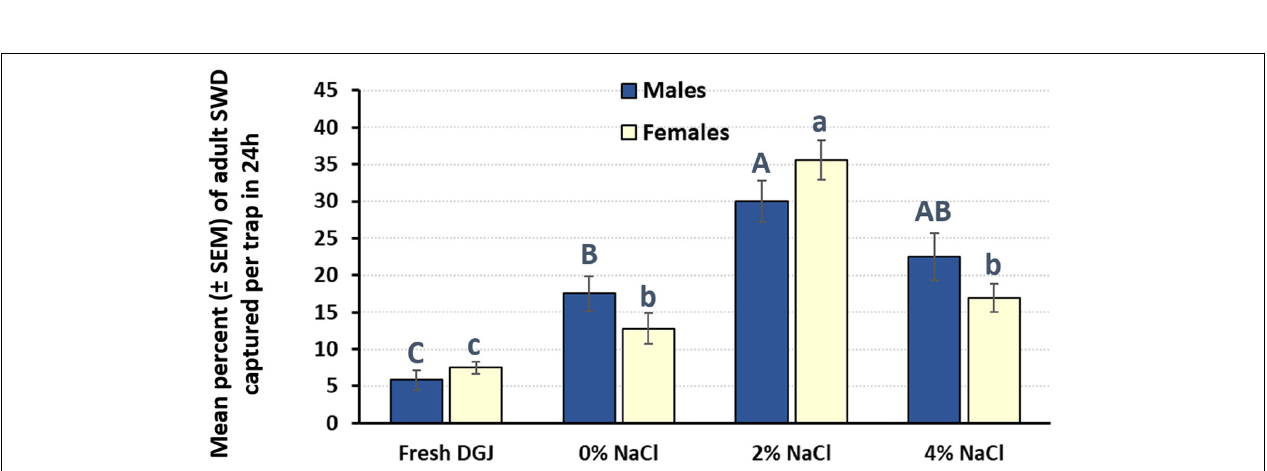
FIGURE 5 | Captures (means ± SEM) of (A) male and female D. suzukii and (B) other drosophilids in traps baited with diluted Concord grape juice according to its level of fermentation. Study conducted in commercial cherry block at the University of Massachusetts Cold Spring Orchard (Belchertown, MA). For each sex of D. suzukii , different letters indicate significant differences according to ANOVA and HSD Tukey tests at P = 0.05.